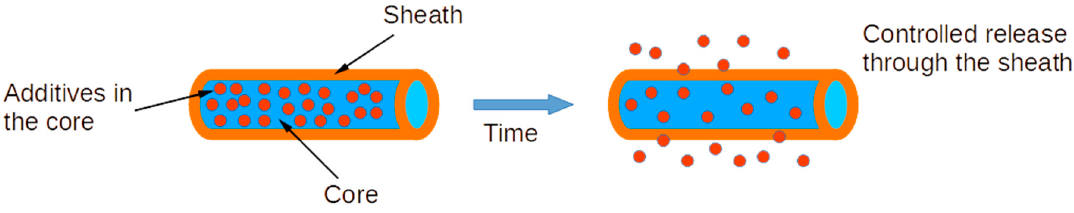
Figure 1. Scheme of the encapsulation and release procedure [33].